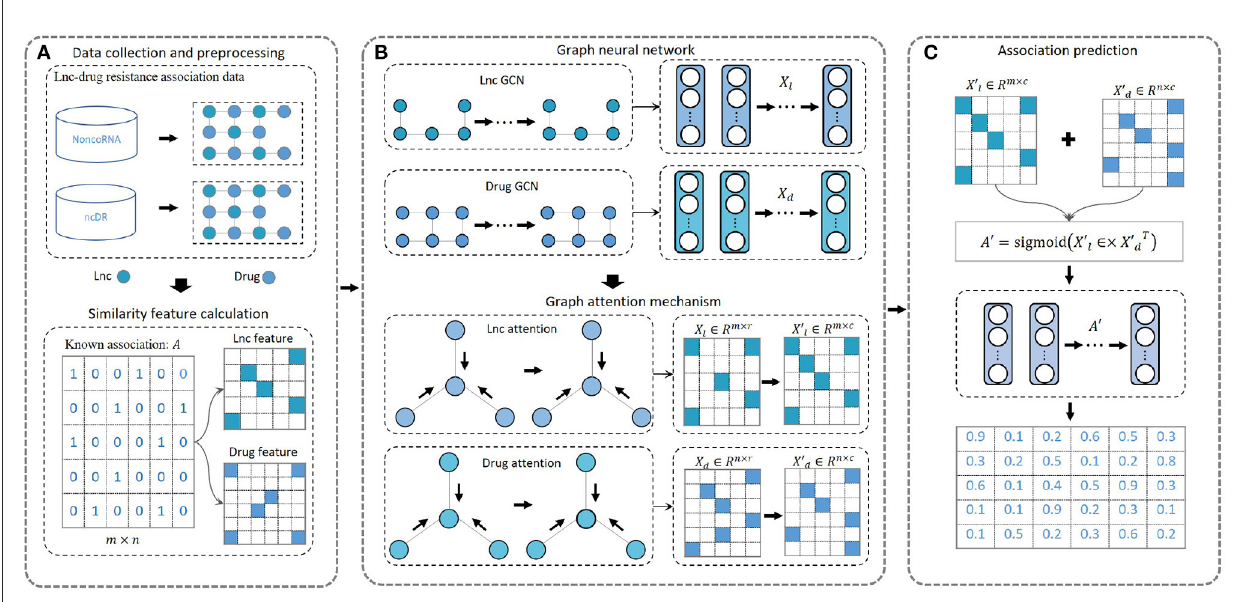
FIGURE1 Overview of DeepLDA. (A) Known lncRNA-drug resistance association network. (B) Graph neural networks are used to initially learn lncRNA and drug features. Graph attention mechanism are used to learn lncRNA and drug embeddings. (C) Using learned embeddings to predict association scores for lncRNA-drug resistance items.